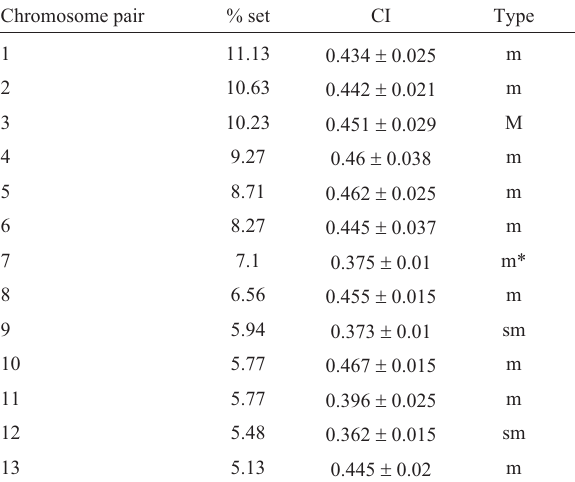
Table 1 - Morphometric data of Bolitoglossa paraensis chromosomes. (CI = centromeric index; % set = relative size; chromosome type: m = metacentric, sm = submetacentric; * = NOR-bearing chromosome pair). Chromosome pair %